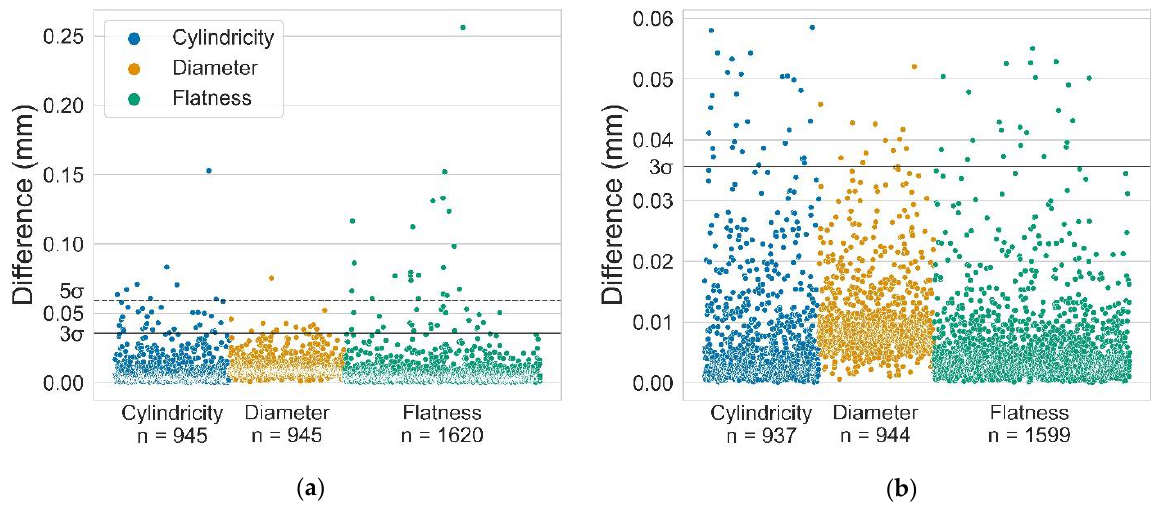
Figure 19. Difference between repeated measurements (∆) of cylindricity, diameter, and flatness. ( a ) Scatterplot, including all data points; ( b ) scatterplot only, including data points within five standard deviations (5σ).